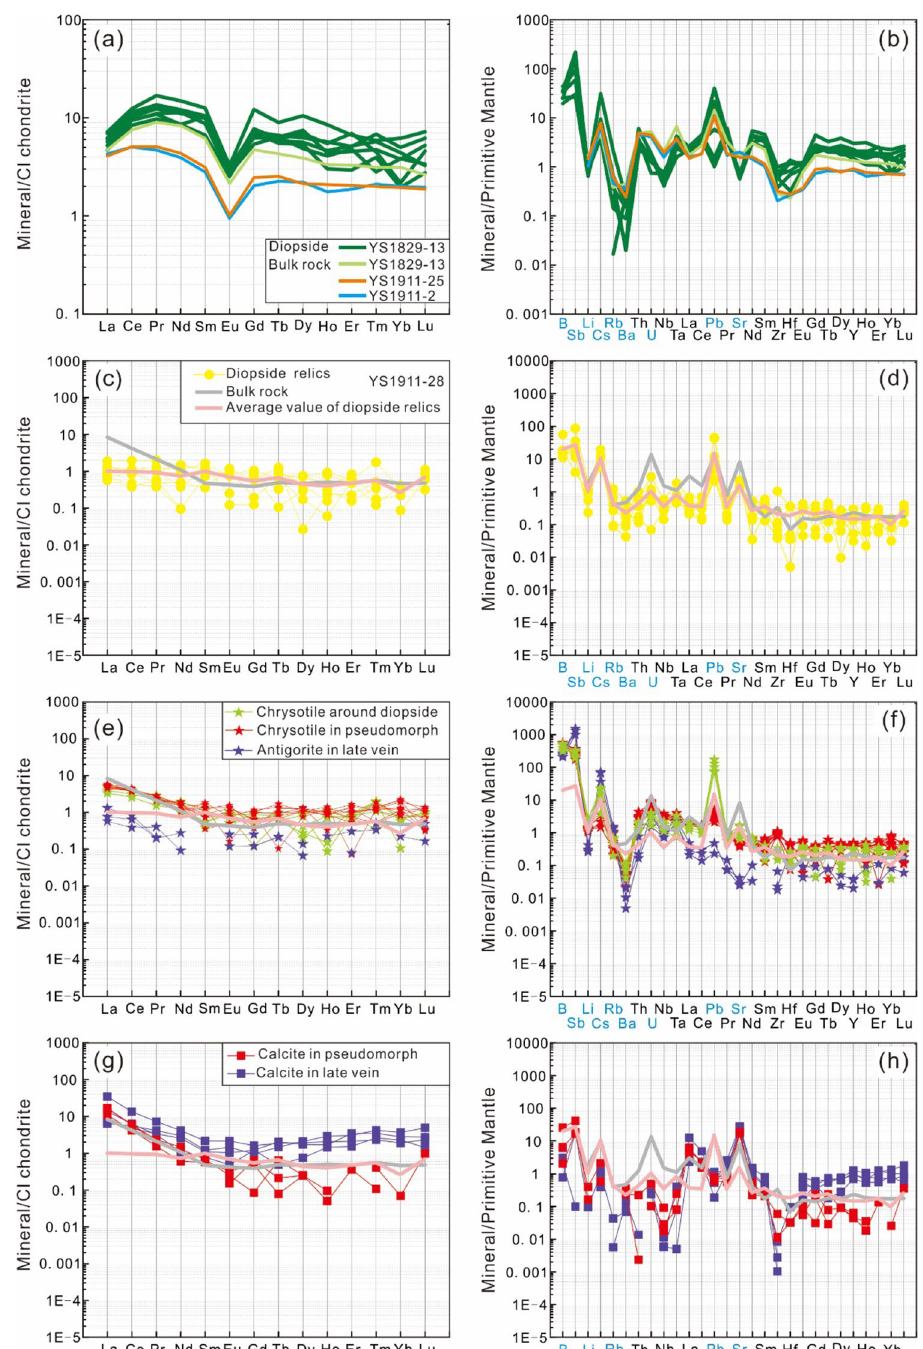
Figure 7. Chondrite- and primitive mantle-normalized diagrams. ( a, b ) Fresh diopsidites and diopsides; ( c, d ) diopside relics; ( e, f ) serpentines after diopsides and in late veins; ( g, h ) calcites after diopsides and in late veins. The ( a-c-e–g ) and ( b-d-f–h ) patterns are chondrite- and primitive mantle-normalized, respectively; normalizing values are from McDonough and Sun 47 . Blue fonts indicate fluid-mobile elements (FMEs). Grey and pink lines represent the values for the studied serpentinized diopsidite and the average value for diopside relics,